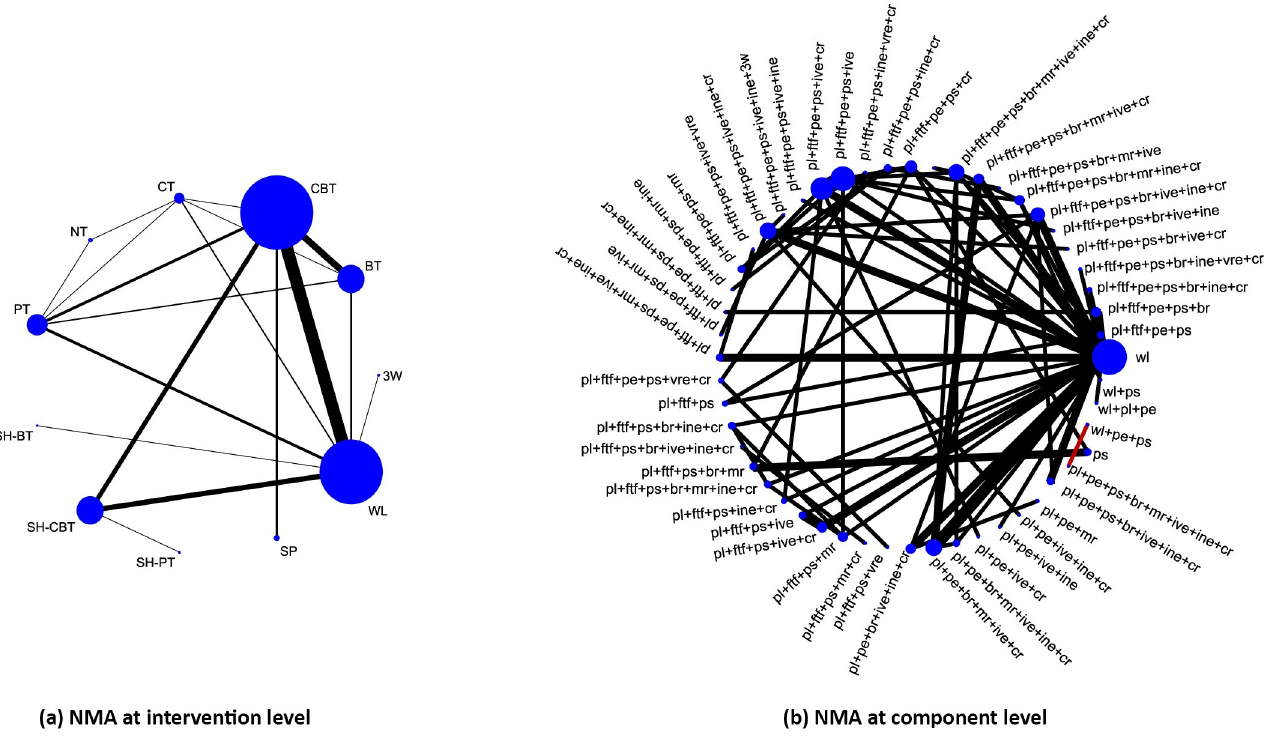
Fig 2. Network plot for psychological interventions at intervention and component level. On the left, we show the network plot at the intervention level (Fig 2(A)). Each circle (node) represents an intervention. Solid lines indicate comparisons for which direct information was available. Abbreviations for 11 interventions: Waiting List (WL); Supportive Psychotherapy (SP); Self Help Physiological Therapy (SH-PT); Self Help Cognitive Behavioral Therapy (SH-CBT); Self Help Behavioral Therapy (SH-BT); Physiological Therapy (PT); No Intervention (NT); Cognitive Therapy (CT); Behavioral Therapy (BT); Cognitive Behavioral Therapy (CBT); Third Wave CBT (3W)). On the right, we show the network plot at the component level (Fig 2(B)). Each node corresponds to a particular combination of components. Abbreviations for 12 components: waiting component ( wl ); placebo effect ( pl ); psychological support ( ps ); psychoeducation ( pe ); breathing retraining ( br ); progressive/applied muscle relaxation ( mr ); cognitive restructuring ( cr ); interoceptive exposure ( ine ); in vivo exposure ( ive ); virtual reality exposure ( vre ); 3w, third-wave components ( 3w ); face-to-face setting ( ftf ).